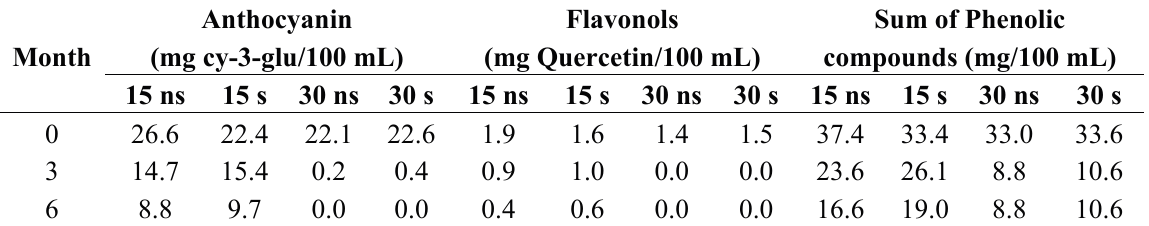
Table 18. Phenolic compound contents in liqueurs made from blackberry fruit at various time and storage intervals